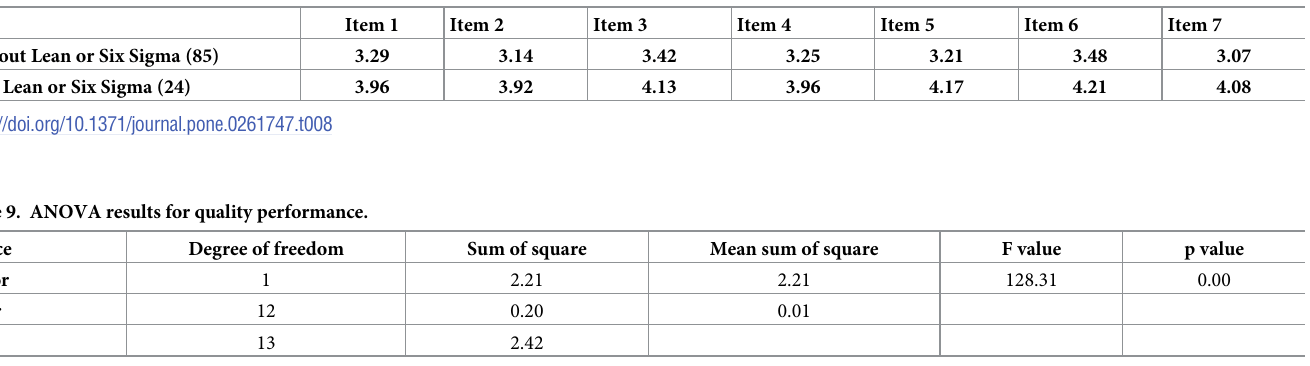
Table 8. Mean scores of items 1 to 7 for quality performance.